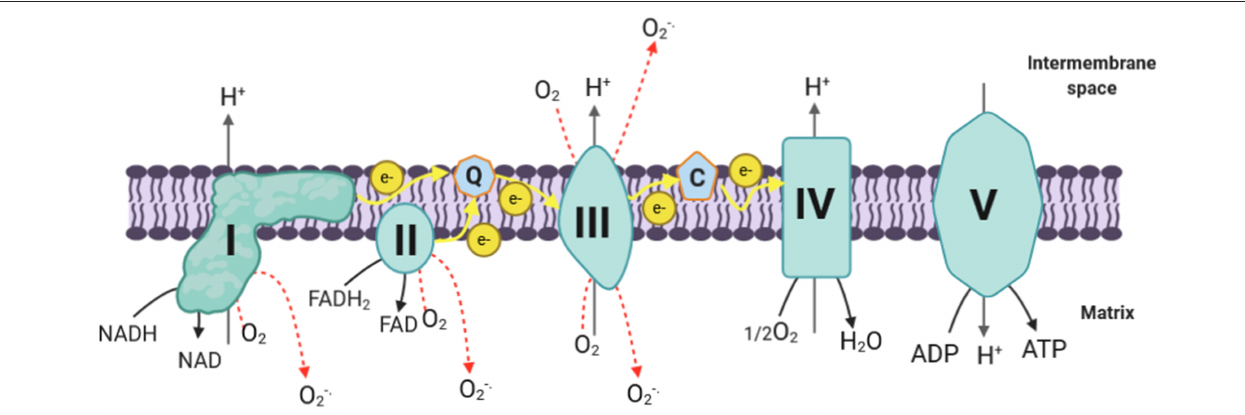
FIGURE 1 | mtROS production in ETC. The electrons donated from NADH in complex I and FADH 2 in complex II flow to complex III through ubiquinone, and then they are transferred to complex IV via cytochrome c ; next, the electrons are passed to the molecular oxygen to form water. During this process, complex I, complex III, and complex IV pump protons to the intermembrane space, creating the proton gradient that drives ATP synthesis. During the process of oxidative phosphorylation, electrons leak and interact with molecular oxygen to form superoxide (O − . 2 ) in complex I and complex III (which are the major ROS production site in the mitochondria) and complex II. Complex III generates superoxide toward the matrix and the intermembrane space, while complex I and complex II produce ROS only toward the matrix. I, complex I; II, complex II; III, complex III; IV, complex IV; V, complex V; Q, coenzyme Q; C, cytochrome c ; e − , electrons; H + , protons; ADP, adenosine diphosphate; ATP, adenosine triphosphate; NADH, reduced nicotinamide adenine dinucleotide; NAD + , oxidized nicotinamide adenine dinucleotide; FAD, flavin adenine dinucleotide; O 2 , molecular oxygen; O − . 2 , superoxide; H 2 O, water; H 2 O 2 , hydrogen peroxide; SOD, superoxide dismutase; Mn, manganese; Cu, copper; Zn, zinc; mtROS, mitochondrial reactive oxygen species; ETC, electron transport